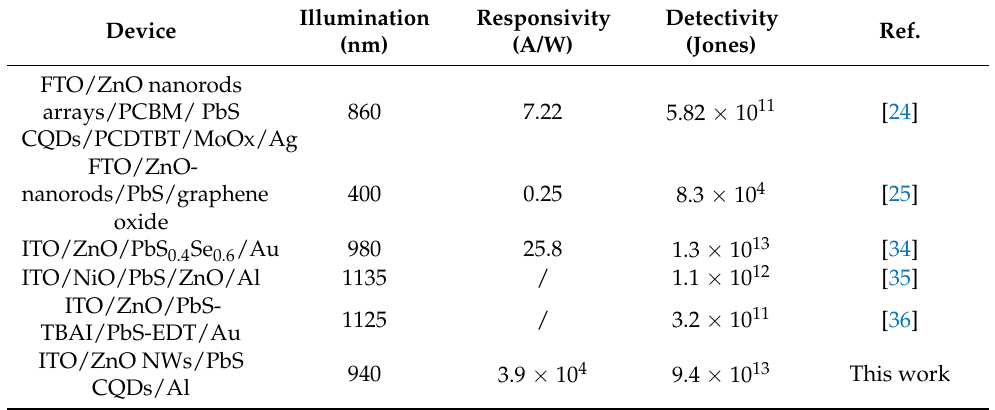
Table 1. List of photodetectors based on PbS CQDs heterojunctions and their performances.